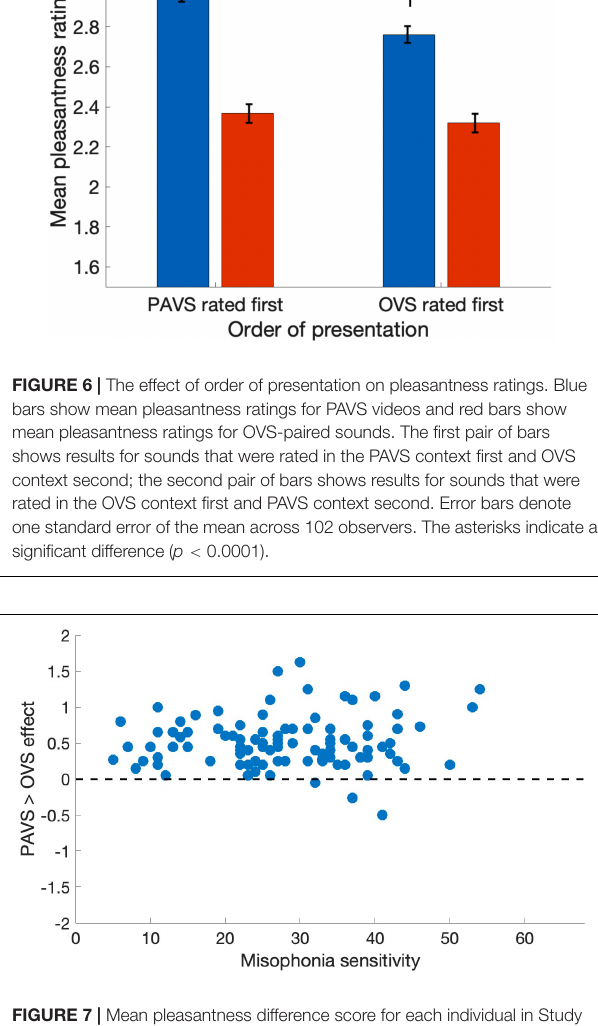
FIGURE 7 | Mean pleasantness difference score for each individual in Study 3, plotted as a function of their total MQ sensitivity score (0–68). Total MQ sensitivity is the sum of an individual’s total for the misophonia symptom scale and the misophonia emotions and behaviors scale.